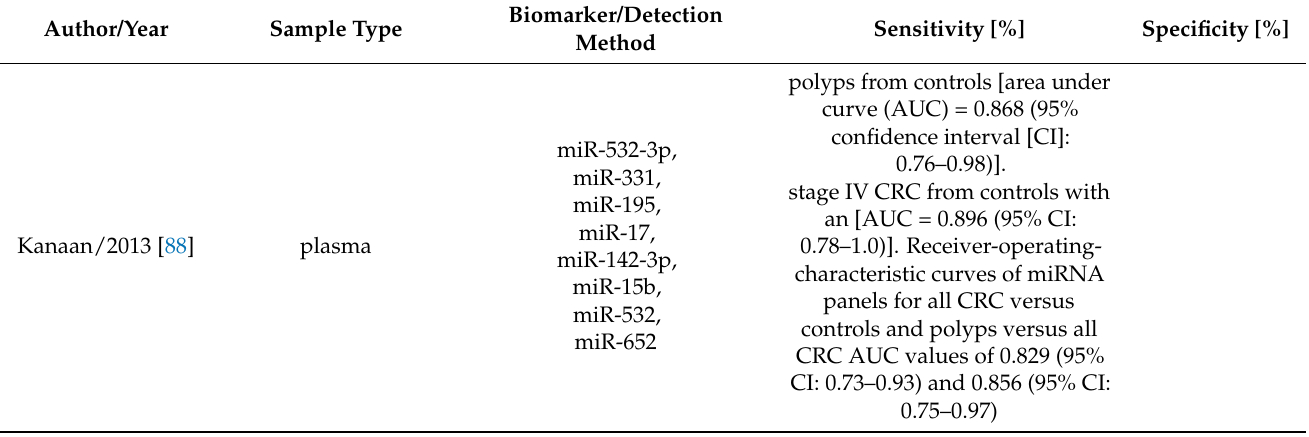
Table 3. According to Loktionov in modification miRNA biomarkers used for CRC detection